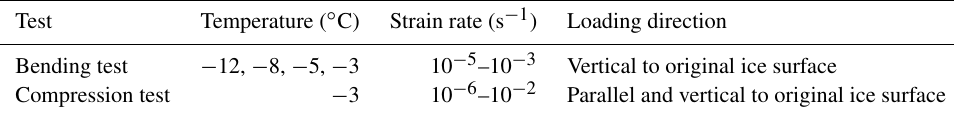
Table 1. The test conditions of bending and compression